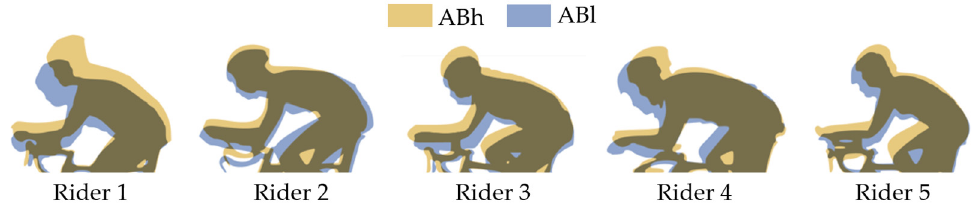
Figure 1. Postures included in the study. ABh / ABl: highest and lowest configurable limits of the aerobars’ height.